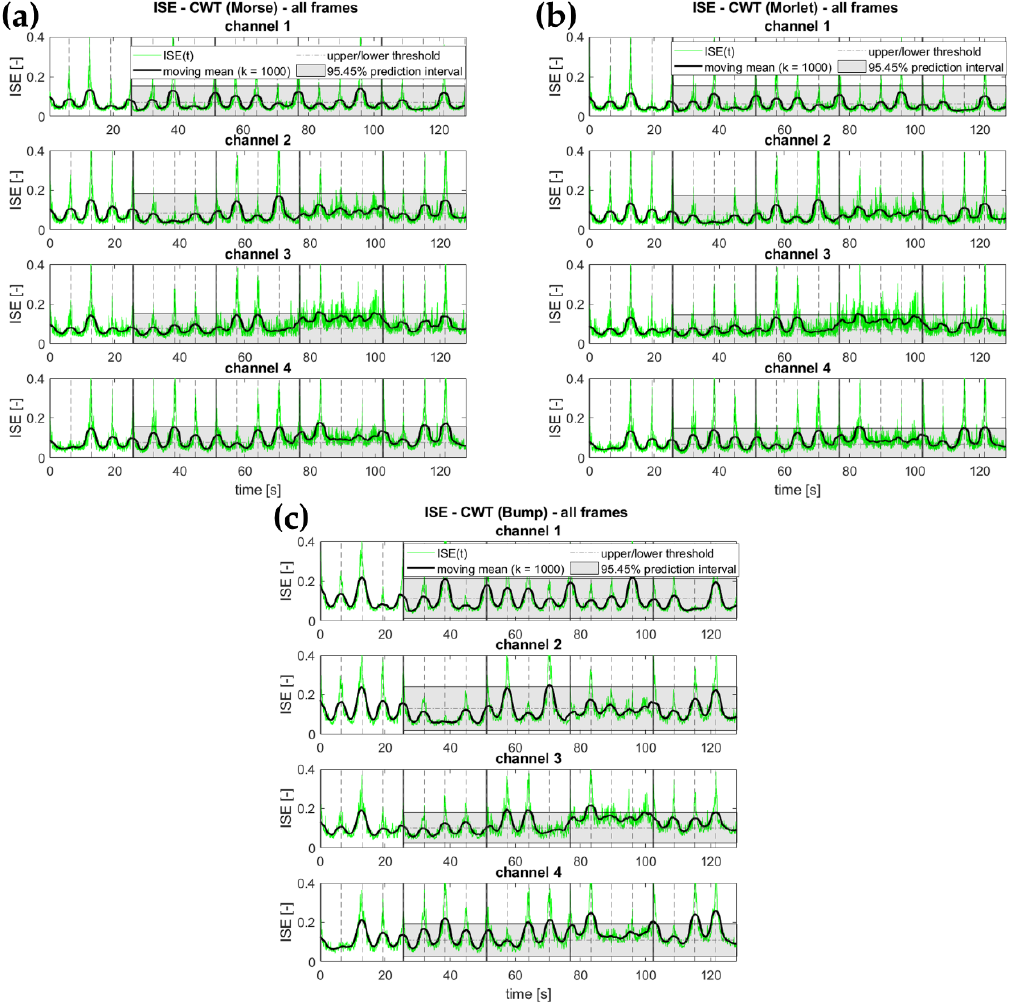
Figure 6. Results for the Wiener entropy. Continuous wavelet transform with ( a ) Morse, ( b ) Morlet, and ( c ) bump wavelets.